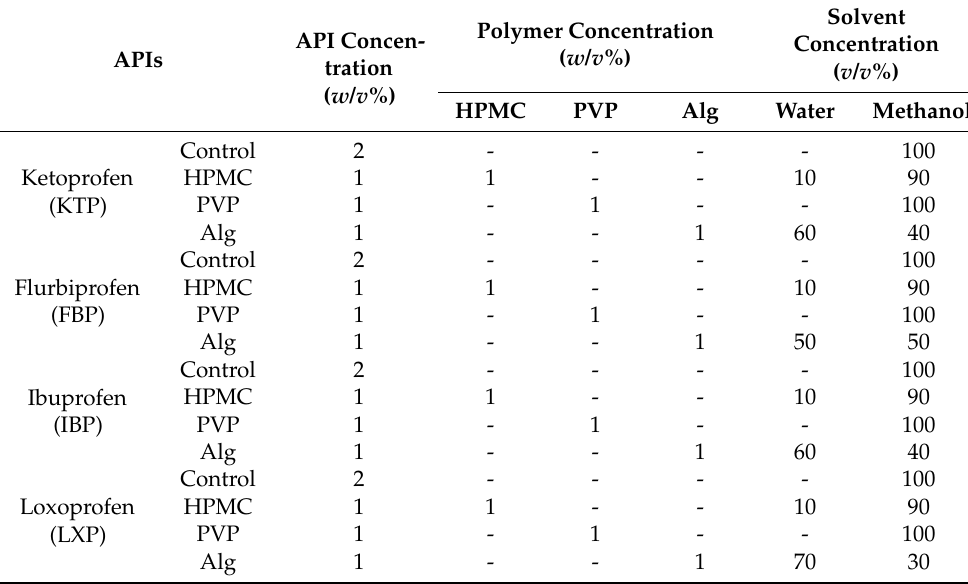
Table 1. Compositions of vacuum dried